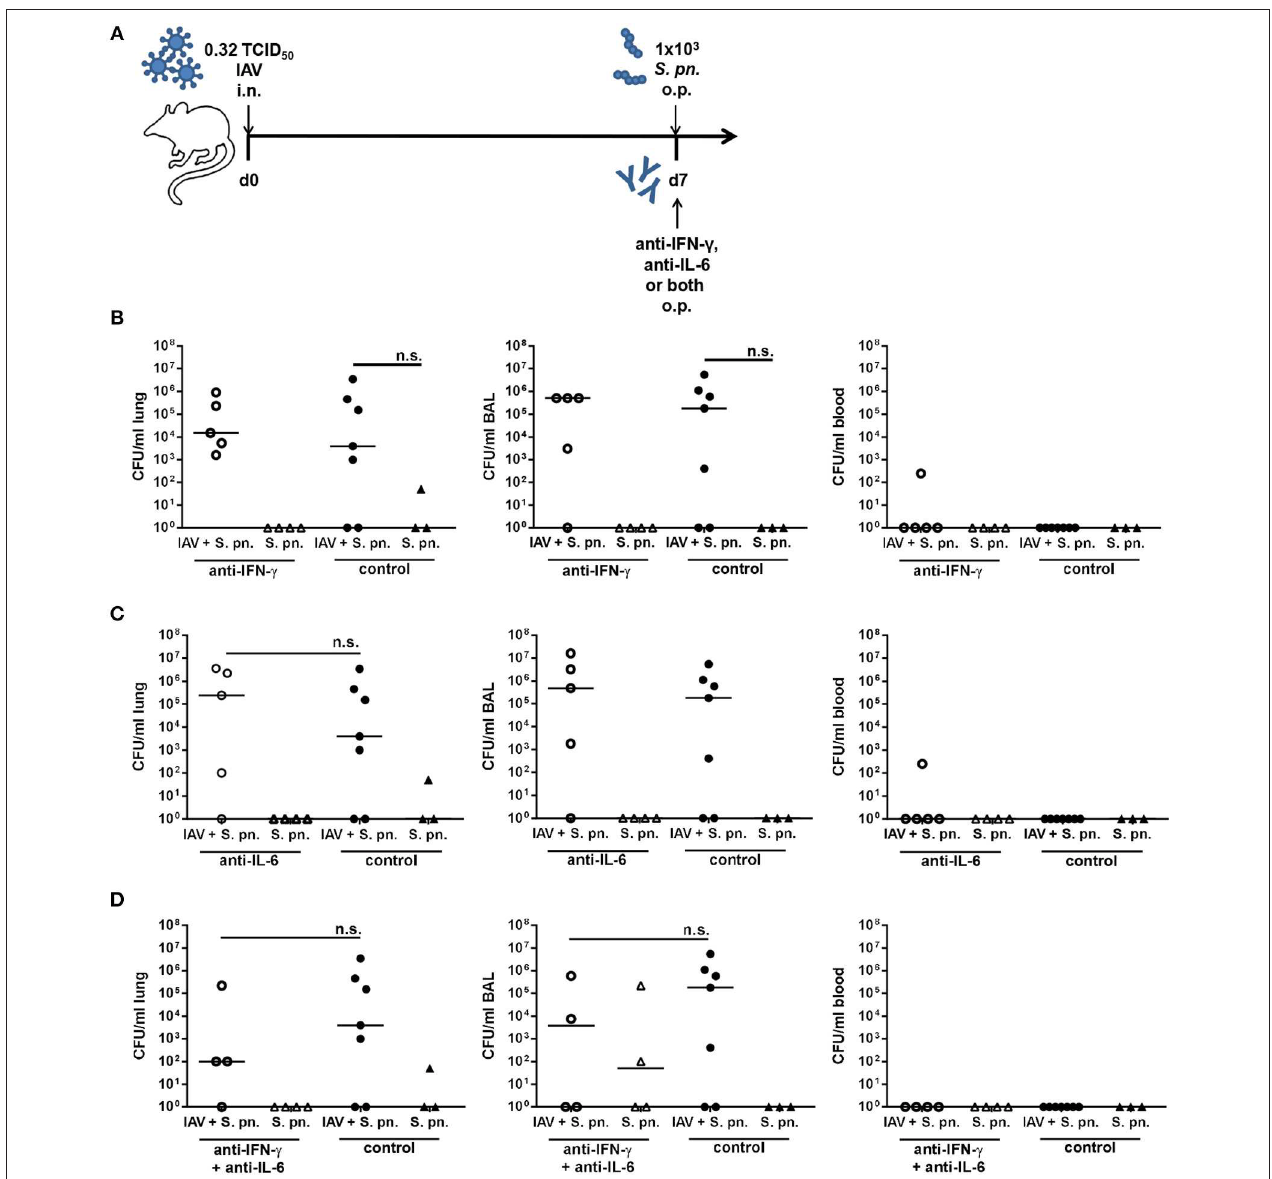
FIGURE 4 | Neutralization of IFN- γ and/or IL-6 during co-infection with 0.32 TCID 50 IAV and 1 × 10 3 CFU S. pn. Mice were infected intranasally (i.n.) with 0.32 TCID 50 IAV or left uninfected on day 0. On day 7, mice were treated with anti-IFN- γ antibody (B) , anti-IL-6 antibody (C) , or both (D) and infected with 1 × 10 3 CFU S. pn. oropharyngeally (o.p.). The control groups were infected likewise and treated with an isotype IgG antibody. (A) Experimental setup. (B–D) S. pn. bacterial counts in lung tissue, BAL and blood 24h post antibody treatment and S. pn. infection. Data are shown for individual mice and lines indicate the median/group. Co-infected, antibody-treated and co-infected control groups were compared using the unpaired, one-sided Mann-Whitney test [n.s., not significant ( p > 0.05)].